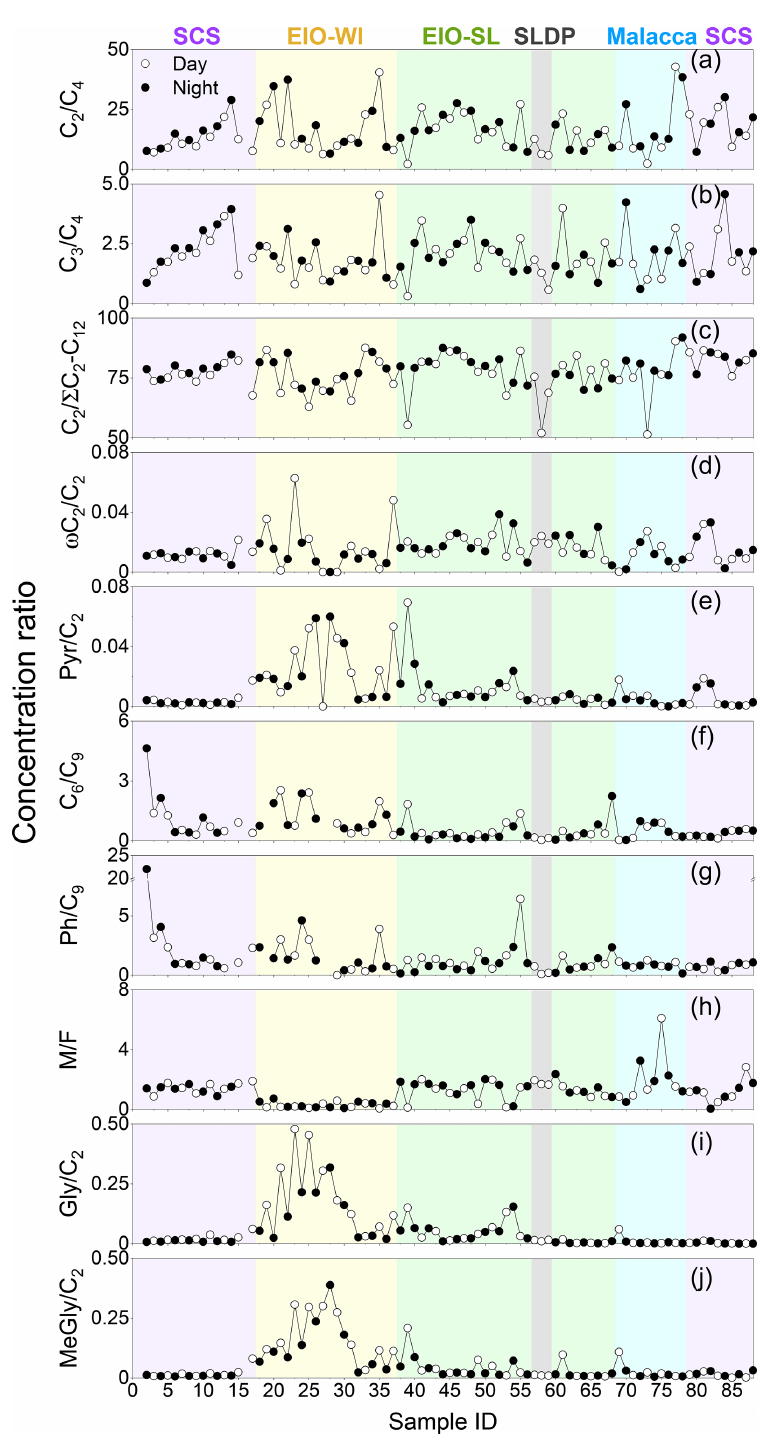
Figure 6. Daily variations in the concentration ratios of (a) C 2 / C 4 , (b) C 3 / C 4 , (c) C 2 /(cid:54) C 2 –C 12 , (d) C 2 /ω C 2 , (e) C 6 / C 9 , (f) C 6 / C 9 , (g) Ph / C 9 , (h) M / F, (i) C 2 / Gly, and (j) C 2 / MeGly in TSP samples collected during the NORC2015-10